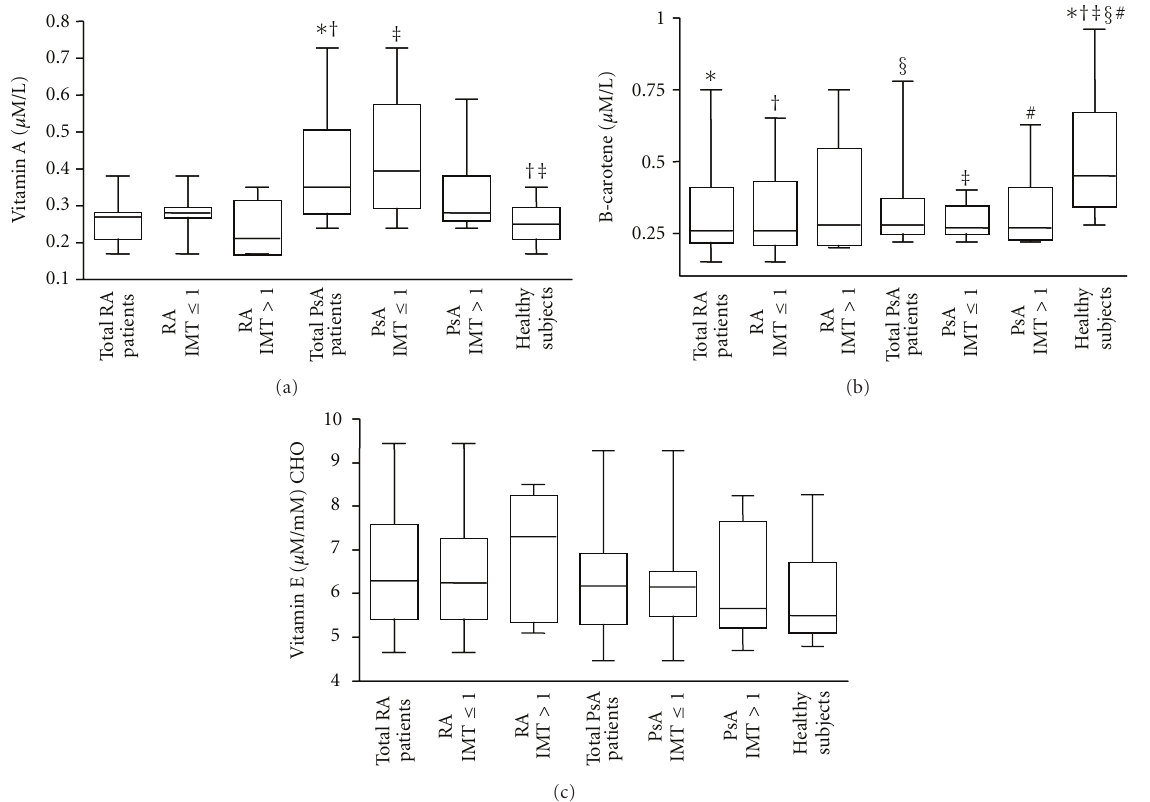
Figure 4: Vitamin concentrations in serum samples . (a) Box plot graphs showing vitamin A concentrations in serum samples from the 24 patients with rheumatoid arthritis (RA) and 25 with psoriatic arthritis (PsA), divided or not according to IMT values obtained by Echo- colour Doppler images and from the 13 healthy subjects. ∗ P = 0 . 0004; † ‡ P = 0 . 0014. (b) β -carotene concentrations in sera. Box plot graphs showing β -carotene concentrations in serum samples from the 24 patients with rheumatoid arthritis (RA) and 25 with psoriatic arthritis (PsA), divided or not according to IMT values obtained by Echo-colour Doppler images and from the 13 healthy subjects. ∗ P = 0 . 0021; § P = 0 . 0008; † P = 0 . 006; # P = 0 . 018; ‡ P = 0 . 0006. (c) Vitamin E concentrations in sera. Box plot graphs showing vitamin E concentrations in serum samples from the 24 patients with rheumatoid arthritis (RA) and 25 with psoriatic arthritis (PsA), divided or not according to IMT values obtained by Echo-colour Doppler images and from the 13 healthy